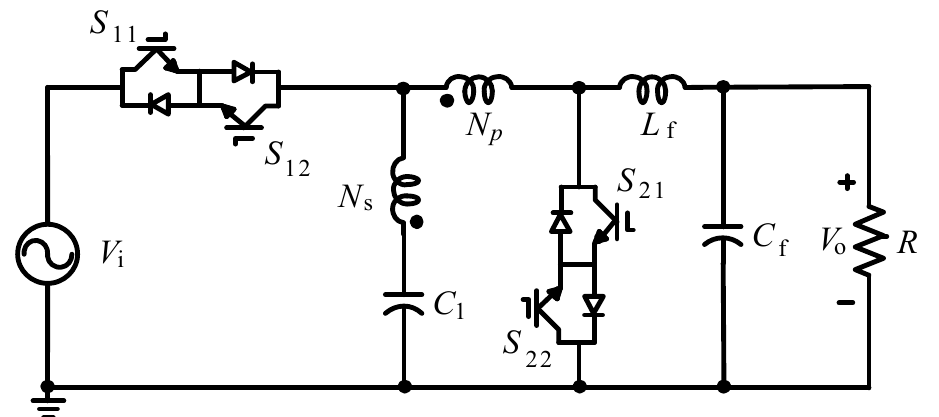
Γ -source converter